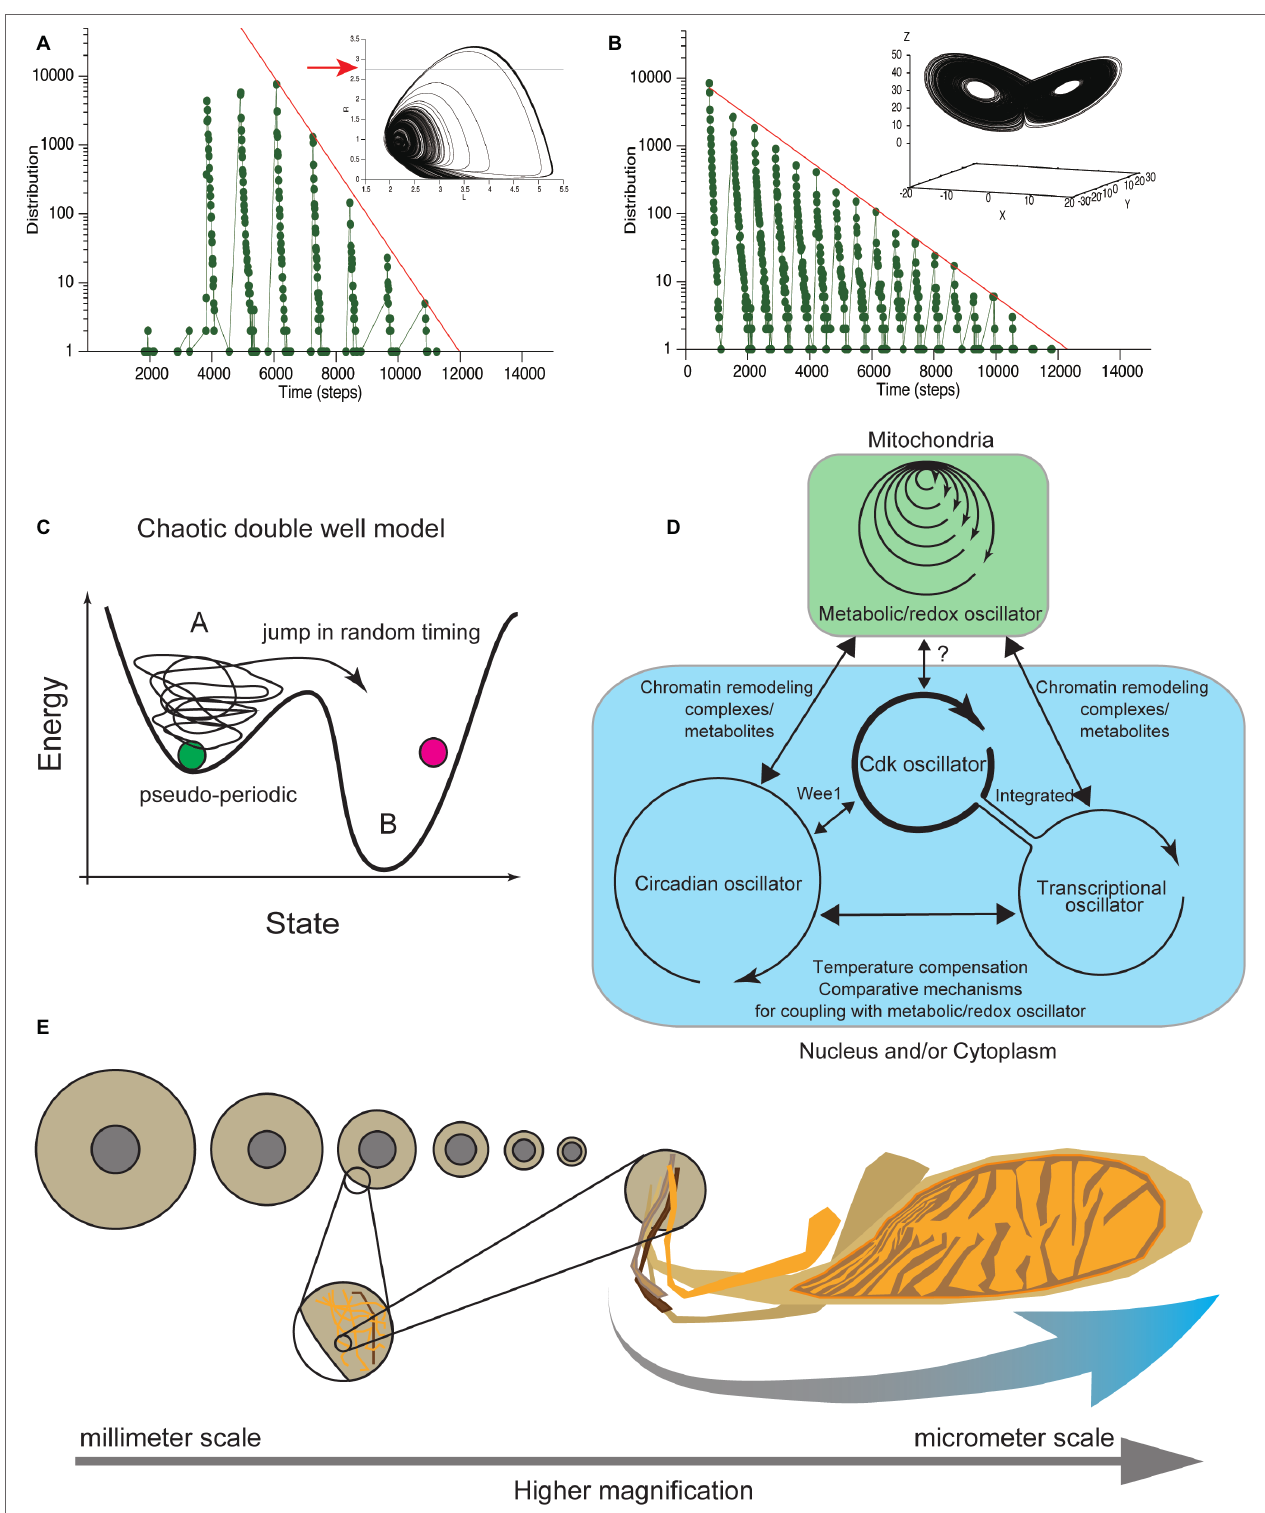
FIGURE 5 | Clustered oscillator for CDC control embedded in different cellular compartments. (A) Cell-cycle durations calculated from Lloyd model (Lloyd et al., 1992) distributed in locally periodic and globally exponential manners. Temporal changes of two variables shown in two-dimensional (phase) space. Coordinate defined by variables follows a characteristic pseudo-periodic orbit (upper), assumed to represent the cellular physiological state. Residence